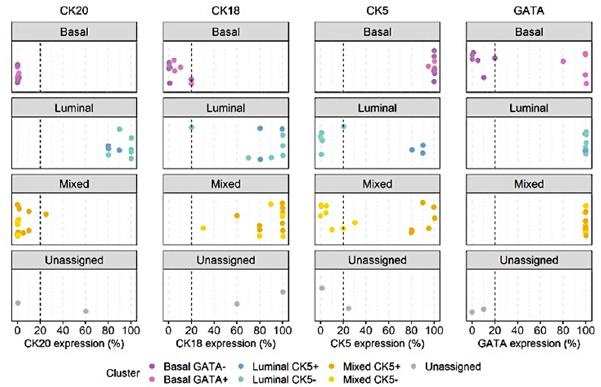
Figure 5. Antibody expression showing the 20% cutoff (dotted vertical line) for each